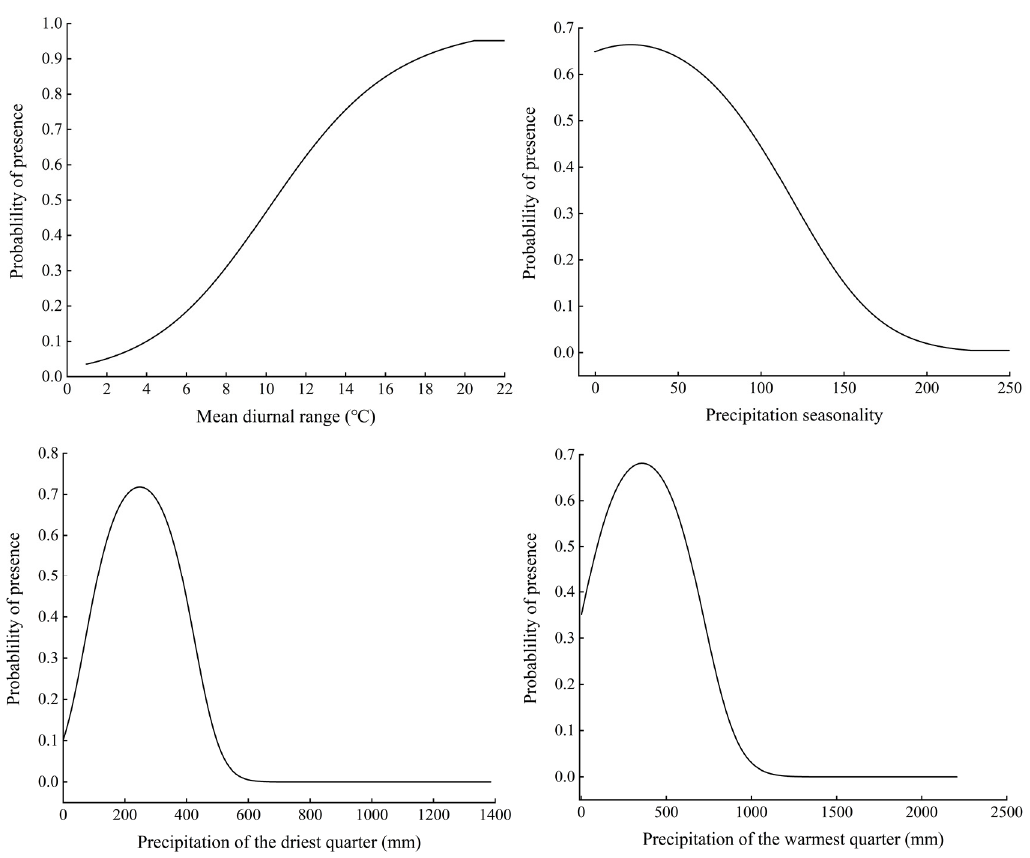
Figure 5. Response curves of probability of presence for Helicoverpa zea .